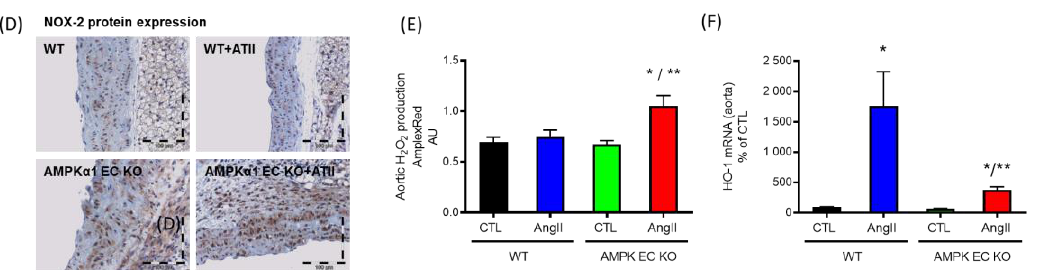
Figure 3. Functions of endothelial specific α 1AMPK. ( A , B ) Epifluorescence intravital microscopy was used to visualize adherent and rolling leucocytes in carotid arteries. Nucleated cells were stained with acridine orange (green fluorescence). Representative images of carotid arteries are shown after 7 days of continuous AT II infusion ( n = 8) before and 60 min after single intraperitoneal injection of anti-CCR2 antibody (anti-CCR2). Deletion of endothelial-specific α 1AMPK (AMPK fl / fl × CadhCre + + AT II) leads to a loss of endothelial barrier function and an enormous AT II-induced increase in CCR-2-dependent recruitment of inflammatory cells to the vascular wall in comparison with the wild-type littermates (CadhCre + + AT II) that was prevented by anti-CCR2 treatment. * p < 0.05 vs. CadhCre + + AT II, ** p < 0.05 vs. AMPK fl / fl × CadhCre + + AT II. ( C ) mRNA expression of MCP-1 was significantly upregulated in aortic tissue of AT II-treated mice lacking α1AMPK in the endothelium ( n = 6), which was accompanied by immune cell infiltration and ( D ) increased NOX-2 protein measured by immunohistochemistry (brown staining) ( n = 4). ( E ) Furthermore, oxidative stress, measured by Amplex Red assay ( n = 4), was significantly increased in mice lacking the endothelial α1AMPK treated with AT II. ( F ) In addition to this, the loss of endothelial α1AMPK impaired the antioxidant defense induced normally by AT II ( n = 11). * p<0.05 vs. WT CTL, ** p<0.05 vs. WT AngII, # p<0.05 vs. AMPK EC KO CTL. Data were reused from [94] with permission. Copyright © 2019, Springer-Verlag GmbH Germany, part of Springer Nature.